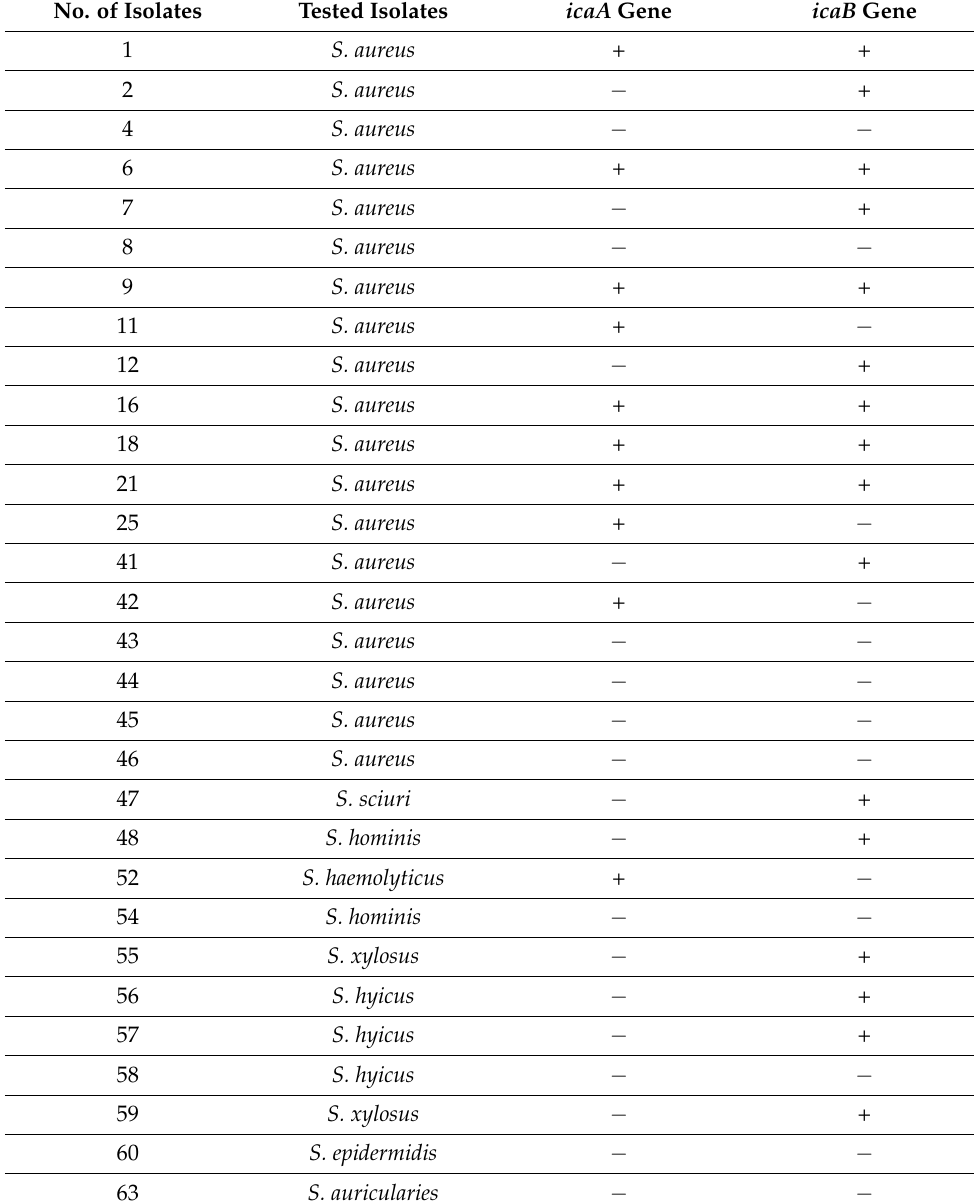
Table 4. Distribution of ( icaA ) and ( icaB ) genes in the strong biofilm-forming isolates within the tested Staphylococcus species isolated from patients, classified as strong biofilm-forming